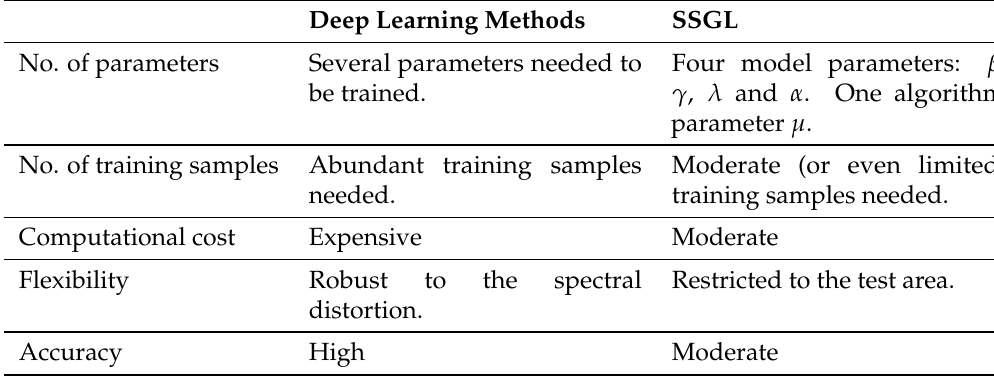
Table 1. Difference between the proposed spatial-spectral graph regularization with location information (SSGL) method and the deep learning